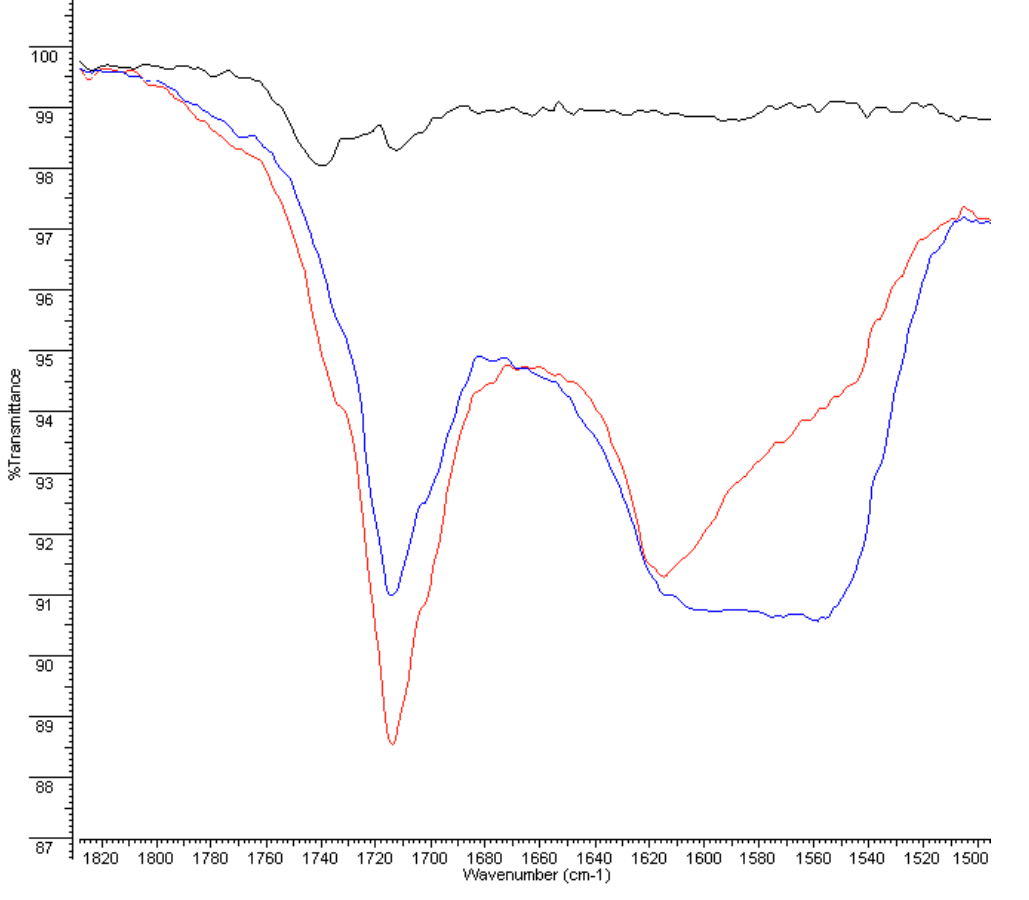
Figure 5. FT-IR spectra of PERT inner surface: new ( black ), 4 weeks ( red ), and 8 weeks Figure 5 . FT-IR spectra of PERT inner surface: new (black), 4 weeks (red), and 8 weeks ( blue )—magnification of 1830–1500 cm − 1 (blue)—magnification of 1830–1500 cm -1 region .